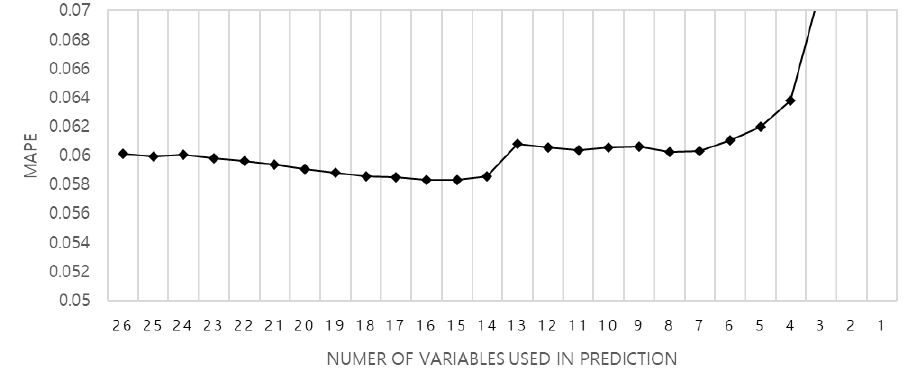
Figure 5. MAPE when removing the least important variables one at a